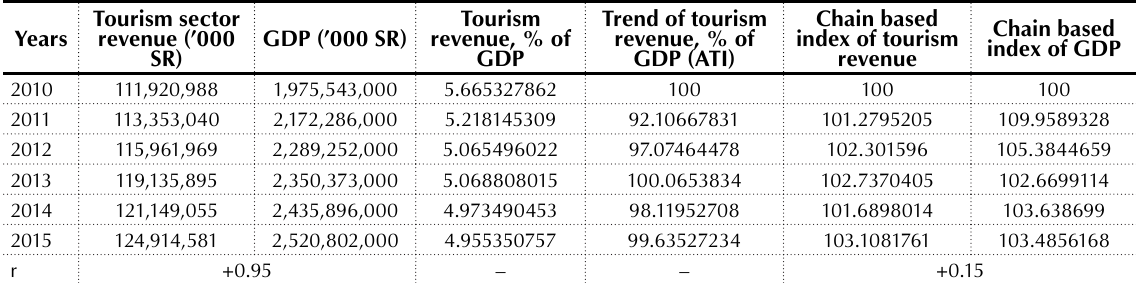
Source: General Authority for Statistics and GDP from SAMA websites.